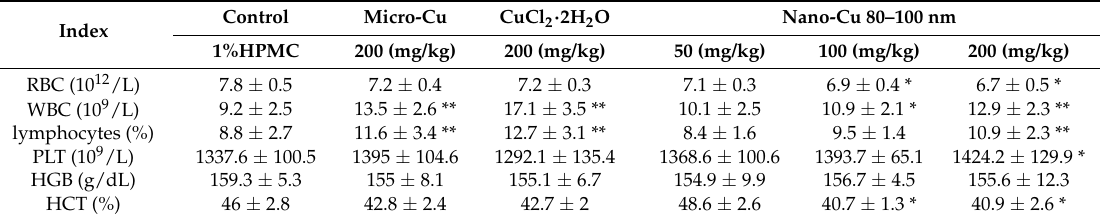
Table 2. Hematologic parameters in rats treated with copper sources by oral administration over 28 consecutive days.